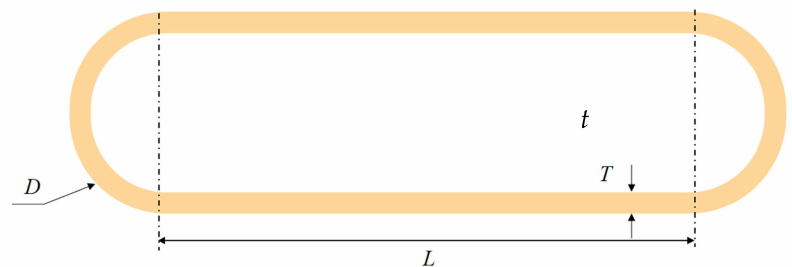
Figure 3. Shape and dimensions of the metal cylindrical shell.